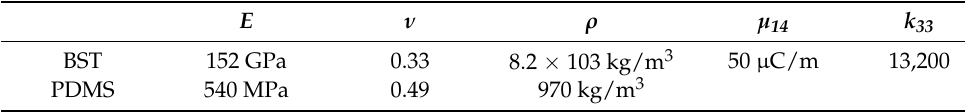
Table 1. Relevant material parameters of BST and